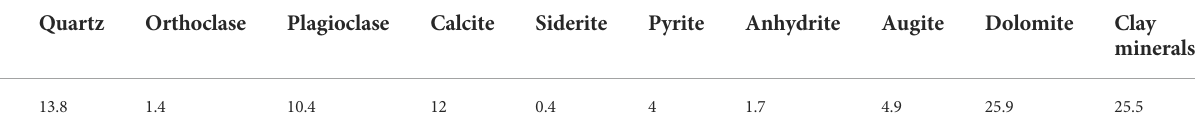
TABLE 1 Mineral composition data of source rock sample (%).